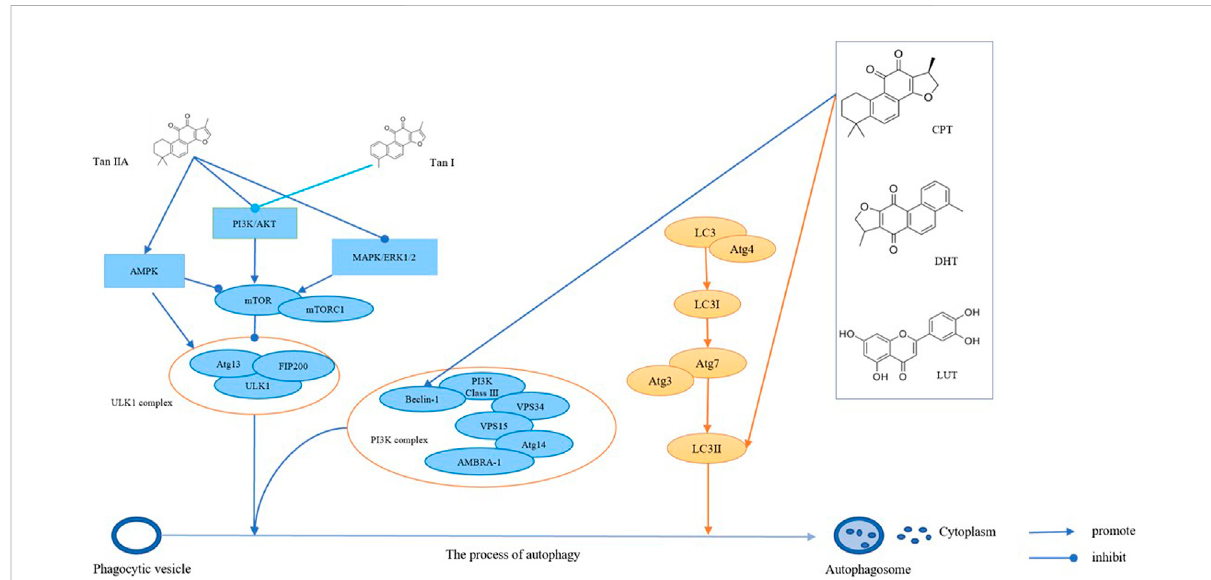
FIGURE 3 The bioactive compounds of S. miltiorrhiza promote autophagy in cancers. Tan IIA and Tan I regulate AMPK signaling, PI3K/AkT signaling, and MAPK/ERK1/2 signaling, thereby regulating mTOR and ULK1 complexes, which promotes the formation of autophagosomes. CPT, DHT, and LUT regulate the PI3K complex and LC3, which in turn promotes autophagosome